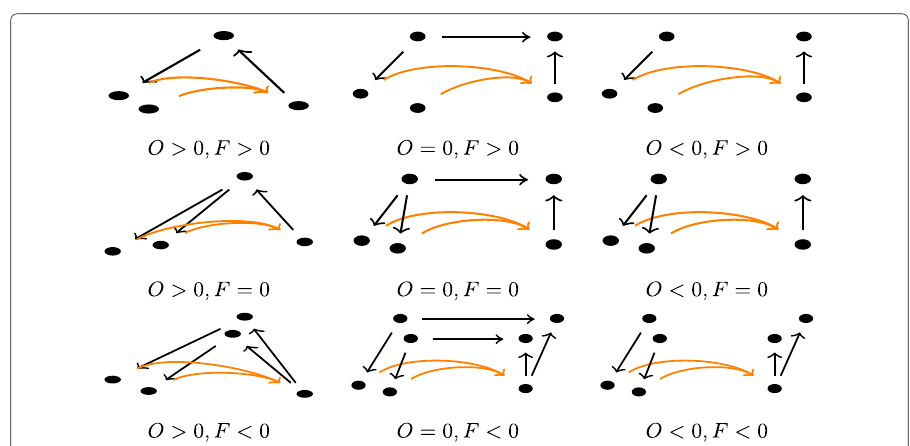
Fig. 1 Local structure of directed hypergraphs with positive, negative and zero values for both Ricci curvatures. For the given orange directed hyperedge e , O ( e ) and F ( e ) correspond to Ollivier and Forman curvatures respectively. From left to right we can detect changes in the signs for Ollivier curvature while the sign of Forman is fixed. On the other hand, when we move vertically in the plot, Forman’s sign change while Ollivier’s sign is fixed. In the diagonal, directed hyperedges have the same sign for both